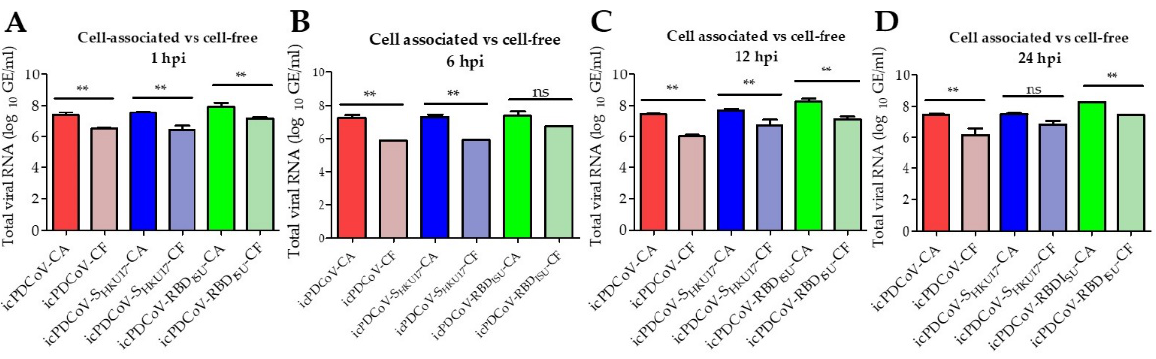
Figure 5. Comparison of viral RNA loads in inoculated DF-1 cells. The DF-1 cells were inoculated with icPDCoV, icPDCoV-S HKU17 , and icPDCoV-RBD ISU viruses at an MOI of 1. Data shown are levels of virus quantified in DF-1 from virus associated with DF-1 compared with the same inoculated DF-1 cells in cell-free fraction at ( A ) 0 hpi, ( B ) 6 hpi and ( C ) 12 hpi, and ( D ) 24 hpi. The cutoff value was 5.17 log10 GE/mL. hpi, hour post infection; GE, genomic equivalent; CA, cell-associated; CF, cell-free. One-way ANOVA with Tukey’s multiple comparisons post hoc test, ** p ≤ 0.05, ns; not statistically significant.